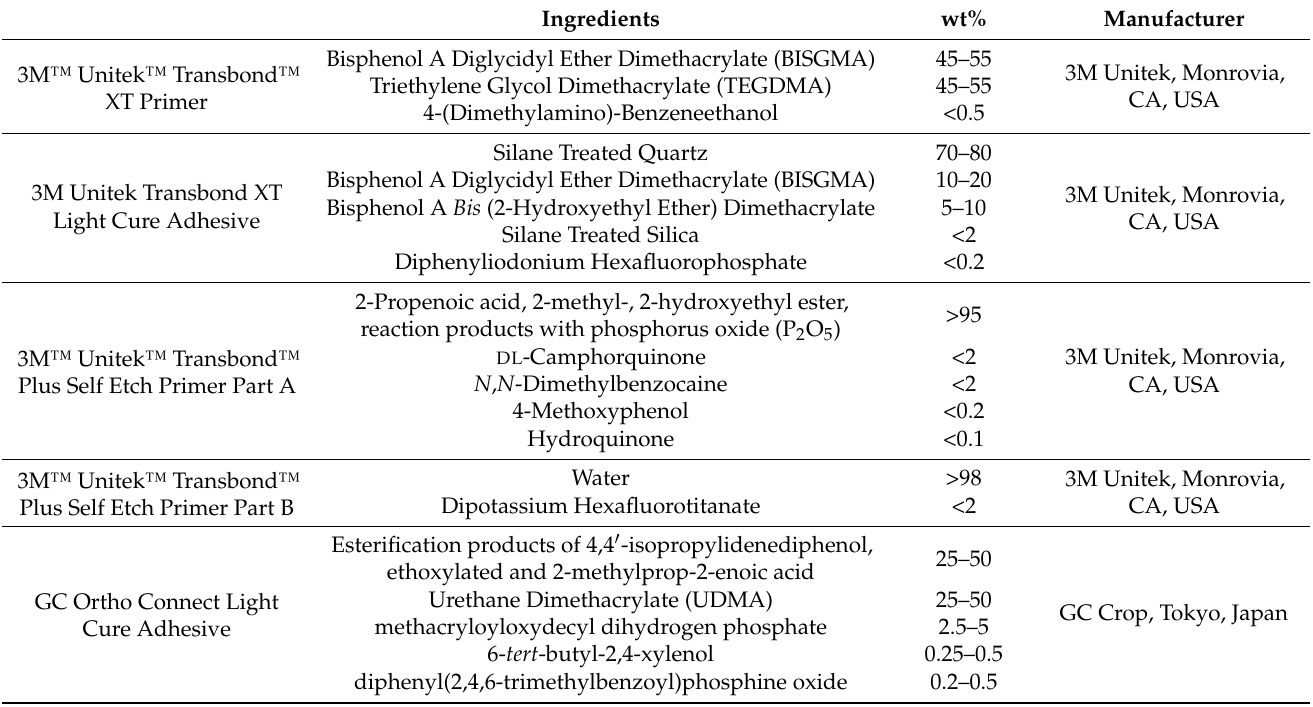
Table 1. Composition on ingredients of